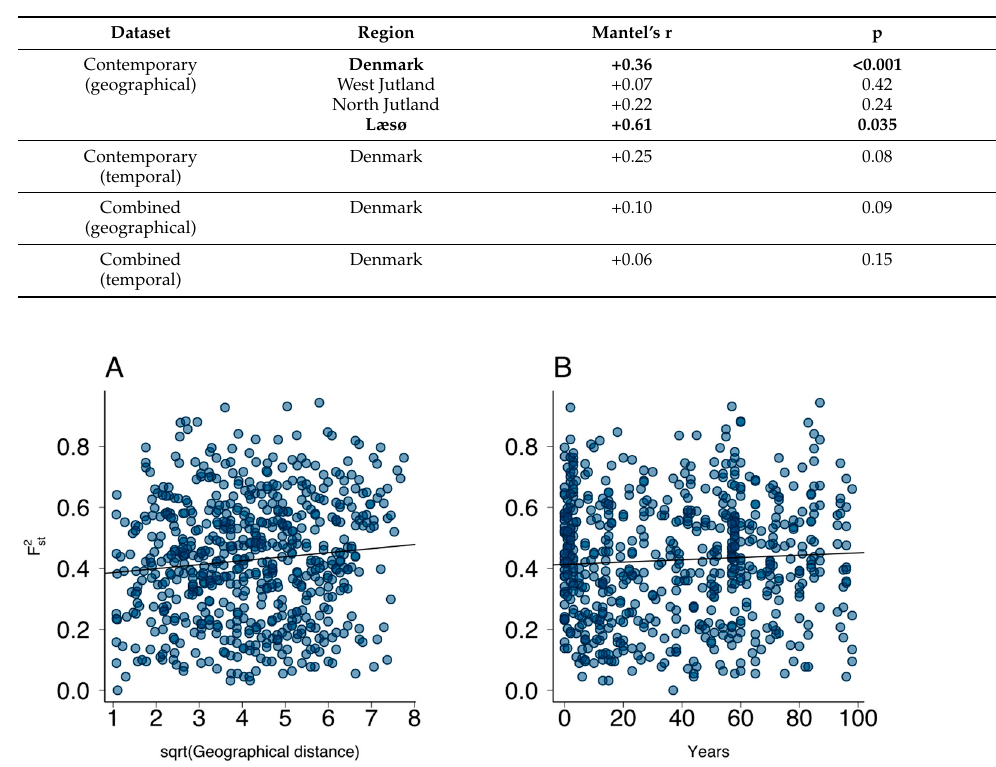
Figure 10. Plots showing isolation by distance ( A ) and year ( B ) for the contemporary dataset. Table 4. Summary of Mantel tests of isolation by distance and isolation by time for the different datasets. The highly significant results for isolation by distance for the contemporary dataset are also broken down by region. Statistically significant associations are shown in bold.